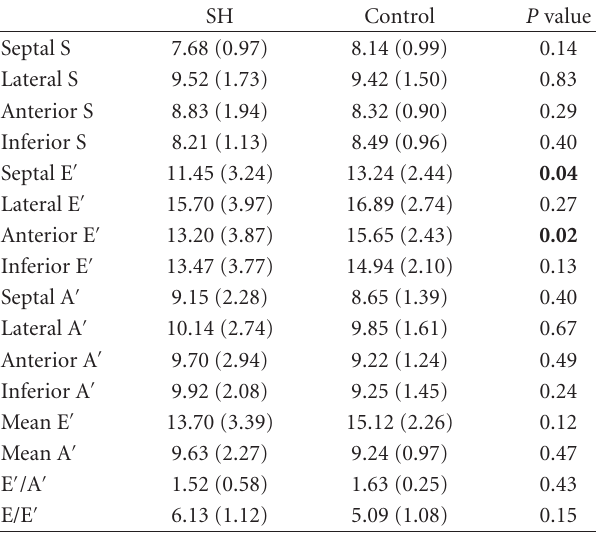
Table 4: Tissue Doppler-derived parameters. Table 5: Response of 2D and M-Mode echocardiographic parame- ters to thyroid hormone replacement